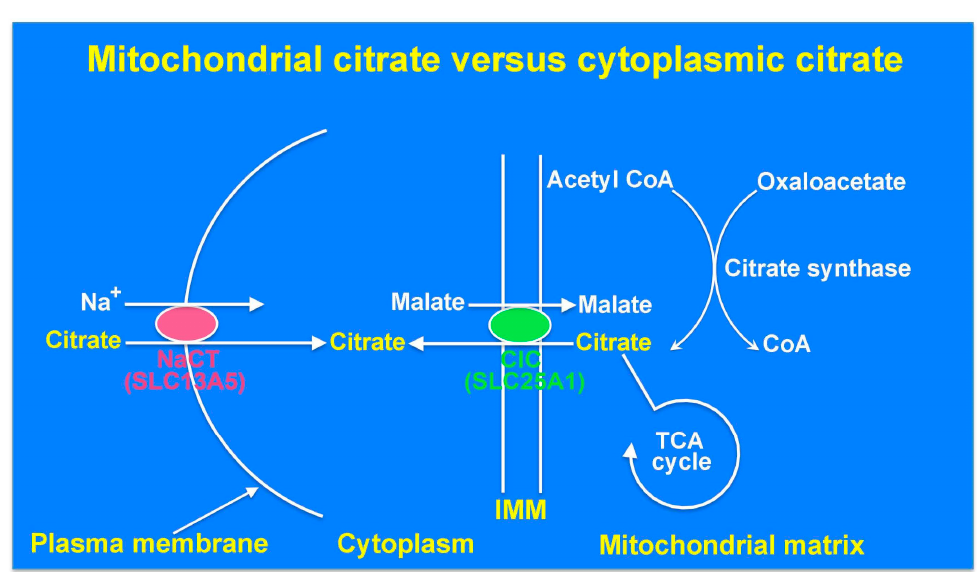
Figure 1. Roles of the mitochondrial citrate transporter SLC25A1 and the plasma membrane citrate transporter SLC13A5 as the determinants of citrate levels in the mitochondrial matrix and the cytoplasm. NaCT, Na + -coupled citrate transporter; CIC, citrate carrier; CoA, coenzyme A; TCA, tricarboxylic acid cycle; IMM, inner mitochondrial membrane.